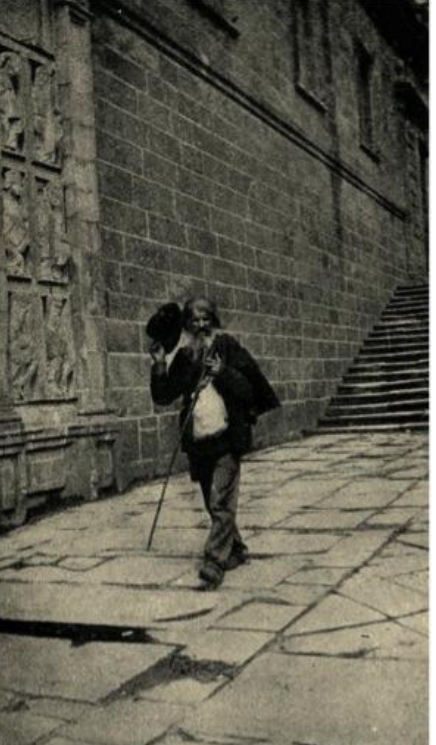
Unidentified photographer, A Beggar by the Puerta Santa, from Georgiana Goddard King, The Way of Saint James , vol. 3 (New Y ork: G.P. Putnam’s Sons, 1920), page 109 (photo: